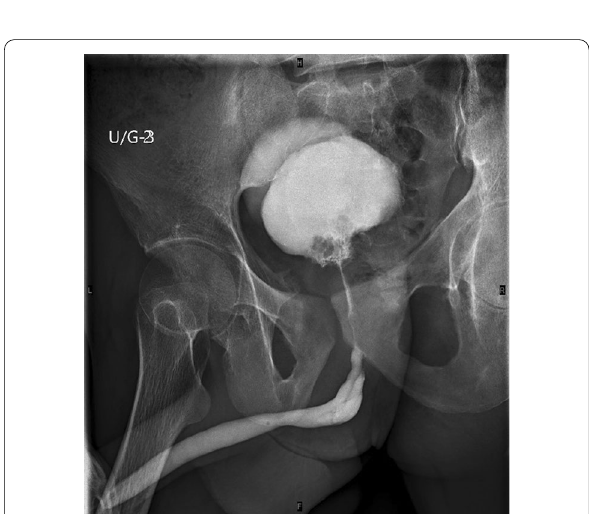
Fig. 1 Urethrogram showing a trabeculated bladder and a filling defect at the bladder